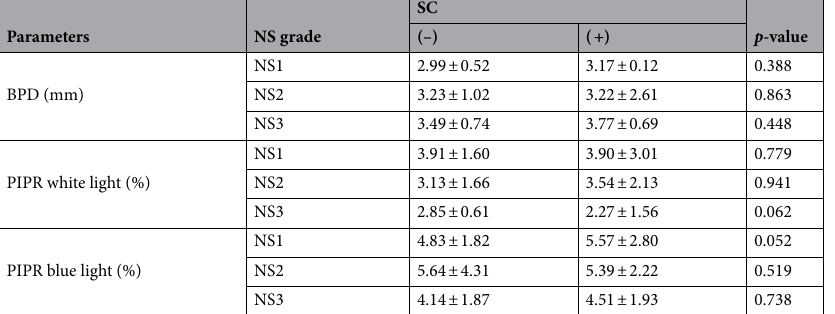
Table 2. Pupillometry parameters in eyes with and without subcapsular cataract. Data are mean ± s.d. p -values indicate the results of comparisons between SC− and SC + in each grade of NS (Mann–Whitney U-tests). BPD baseline pupil diameter, expressed in mm, NS nuclear sclerosis (Emery–Little classification), PIPR post-illumination pupillary response, expressed as % constriction from BPD, SC anterior and/or posterior subcapsular cataract, s.d. standard